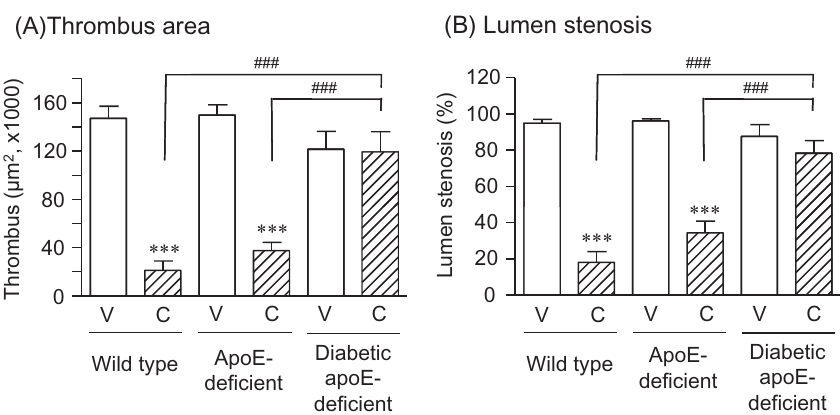
Fig. 4 Effects of clopidogrel on morphometric parameters of injured carotid arteries, thrombus area ( A ) and lumen stenosis ( B ). Clopidogrel (C) at 10 mg/kg/d (orally) or vehicle (V) was administered once daily for 5 days to wild-type (WT), apoE-de fi cient, and diabetic apoE-de fi cient mice ( n ¼ 10 per group) and arterial occlusion was induced 2 hours after the last dose of clopidogrel. After completing blood fl ow monitoring, mice were euthanized. The FeCl 3 -injured regions of the carotid arteries were collected, further fi xed in 10% neutral-buffered formalin and paraf fi n sectionsprepared, and stained. The lumen and thrombotic areas were measured usingan image analysis software (WinROOF 2013), and lumen stenosis (100 (cid:1) thrombus area/lumen area) was calculated. Results are presented as the mean þ SE ( n ¼ 10). (cid:5)(cid:5)(cid:5) p < 0.001 versus each vehicle group, ### p < 0.001 (Student ’ s t